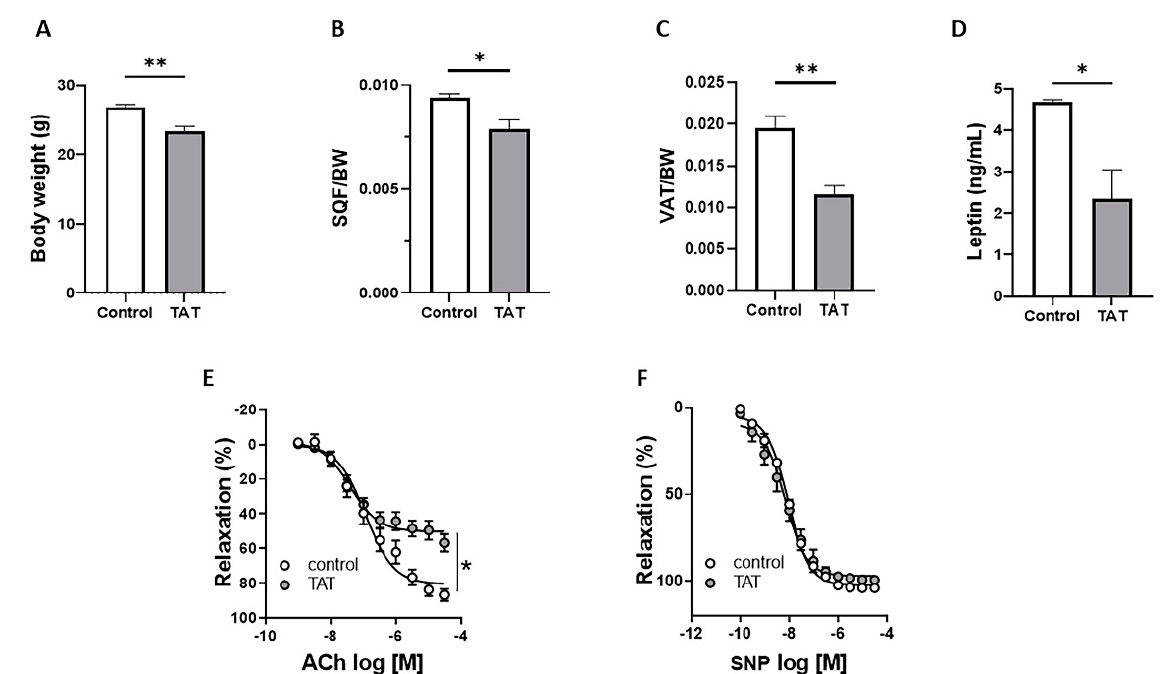
Figure 1. Tat induces endothelial dysfunction. Body weight ( A ), subcutaneous fat depot (SQF/BW; B ), visceral fat depot (VAT/BW; C ) plasma leptin levels ( D ), concentration response curves (CRC) to acetylcholine (Ach; E ) and sodium nitroprusside (SNP; F ) in aortic rings from control (vehicle-treated) and TAT-treated mice (TAT, 3.2 µg/kg per day for 4 weeks, i.p.). Data are presented as mean ± SEM. n = 5–6; * p < 0.05; ** p < 0.01 vs. Ctrl.